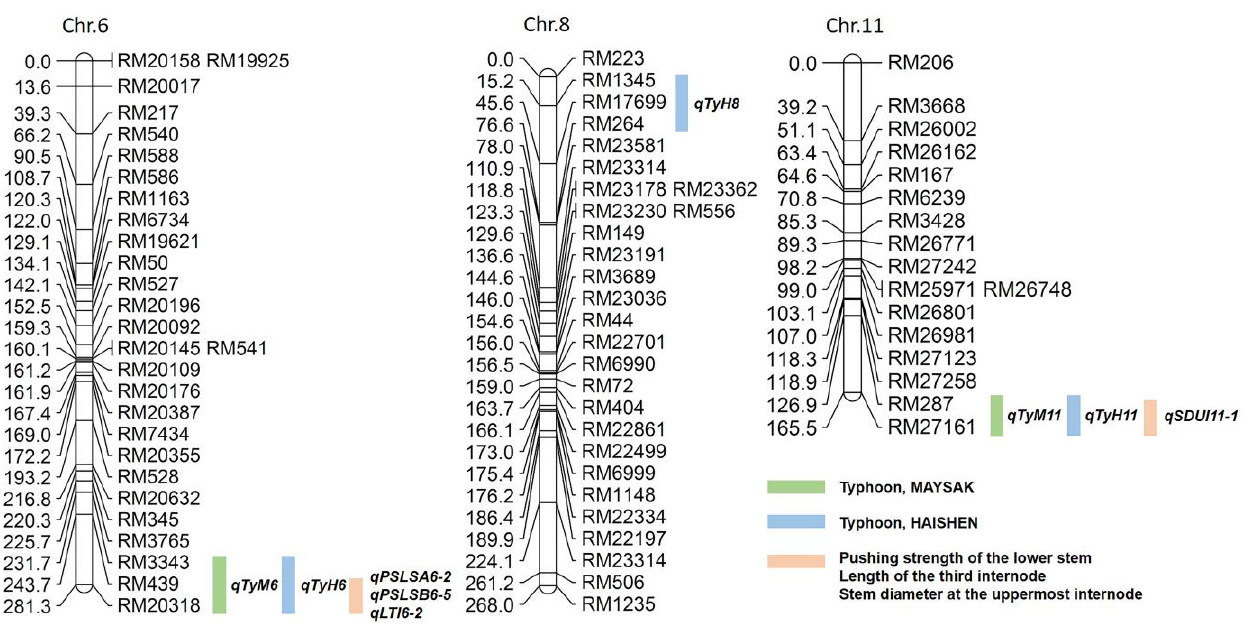
Figure 3. The location of QTLs on chromosomes associated with lodging resistance to typhoons in the CNDH population. QTL analysis suggests that genes related to lodging resistance to typhoons are located on chromosomes 6, 8, and 11.